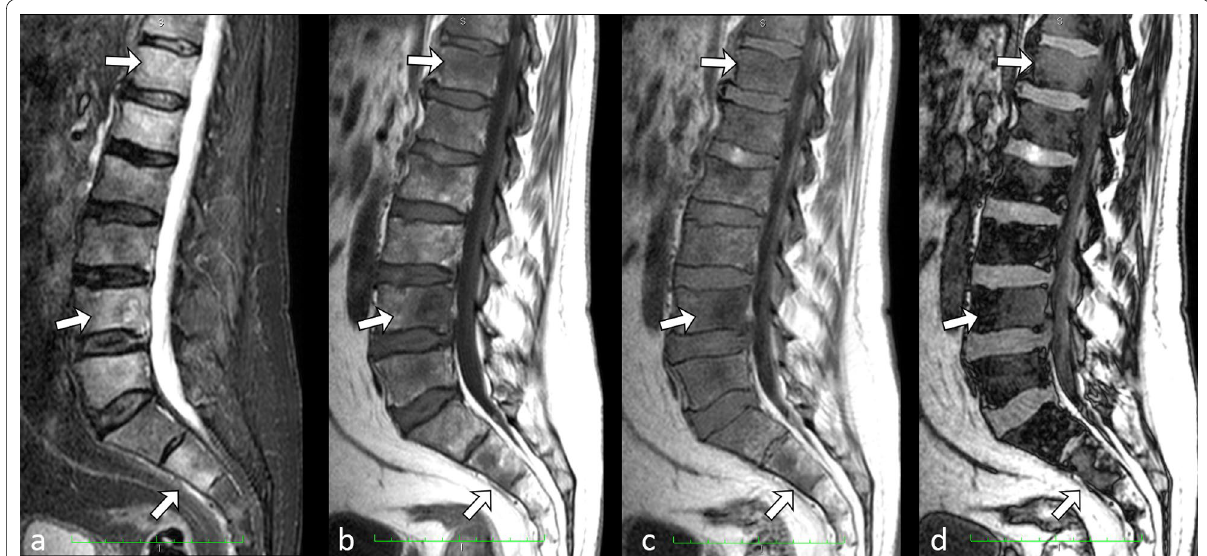
Fig. 3 Sagittal short inversion time inversion recovery (STIR) ( a ) and T1-w. turbo spin echo (TSE) ( b ) series showing multiple, ill-defined, lumbar vertebral body metastatic lesions in a 57-year-old patient with known lung cancer. Sagittal in-phase ( c ) and opposed-phase ( d ) gradient echo (GE) T1-w. series in the same patient. Opposed-phase image shows with great advantage and better details the various lesions, as areas of red bone marrow substitution. Arrows indicate the most prominent lesions